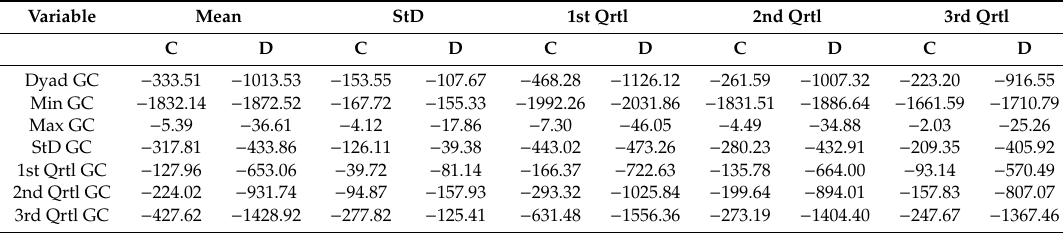
Table 1. Descriptive statistics, Study 1, per experimental condition.